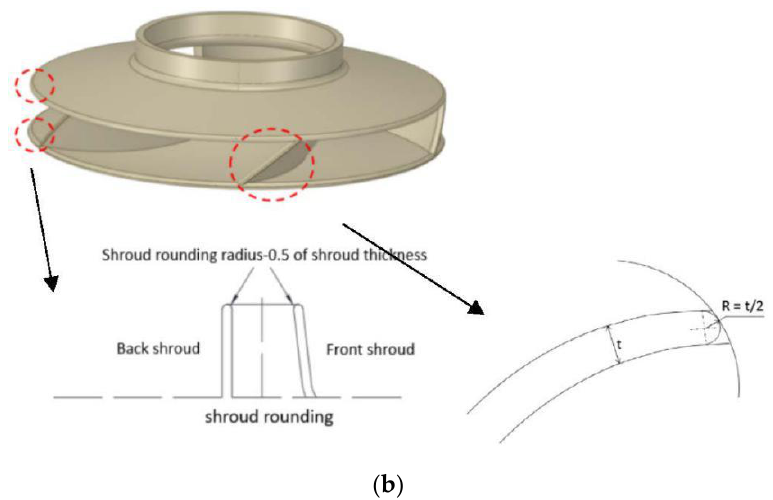
Figure 5. Model comparison before and after impeller rounding. ( a ) Original impeller; ( b ) rounded impeller and roundness details of the impeller ( t = blade thickness, R = radius of blade rounding).